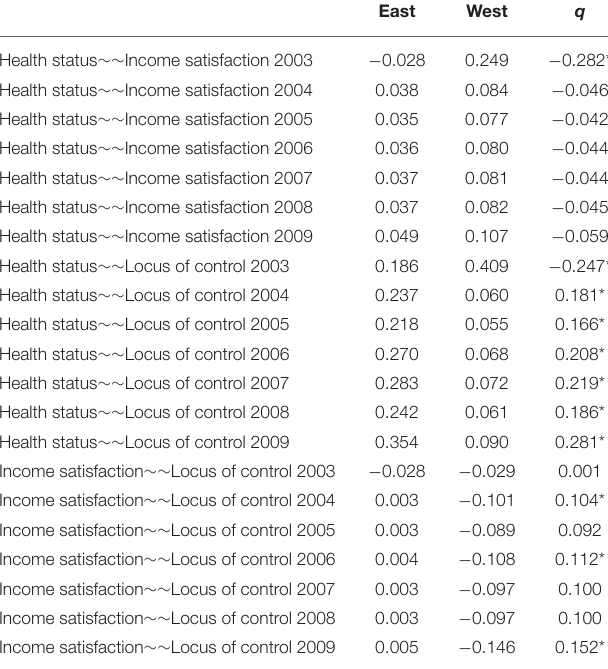
TABLE 6 | Cross-correlation effects.